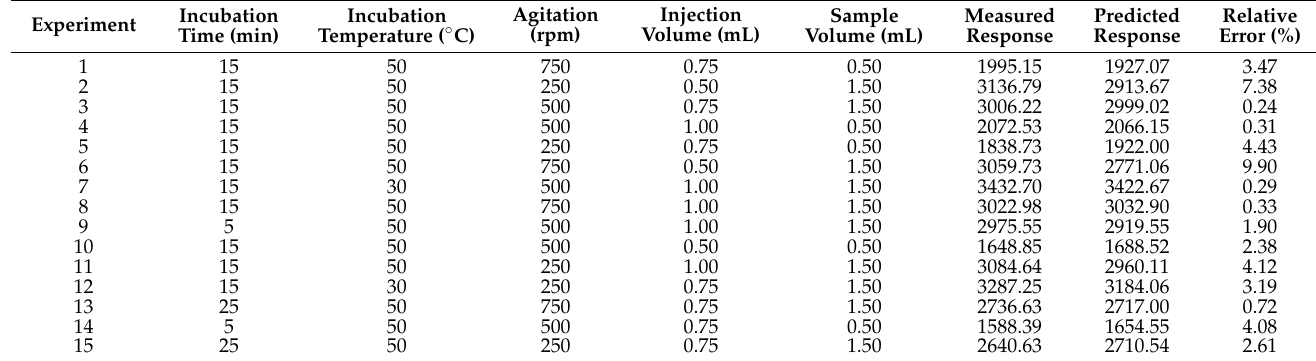
Table A1. Box-Behnken design matrix with the values of the six variables for each experiment and measured and pre- dicted